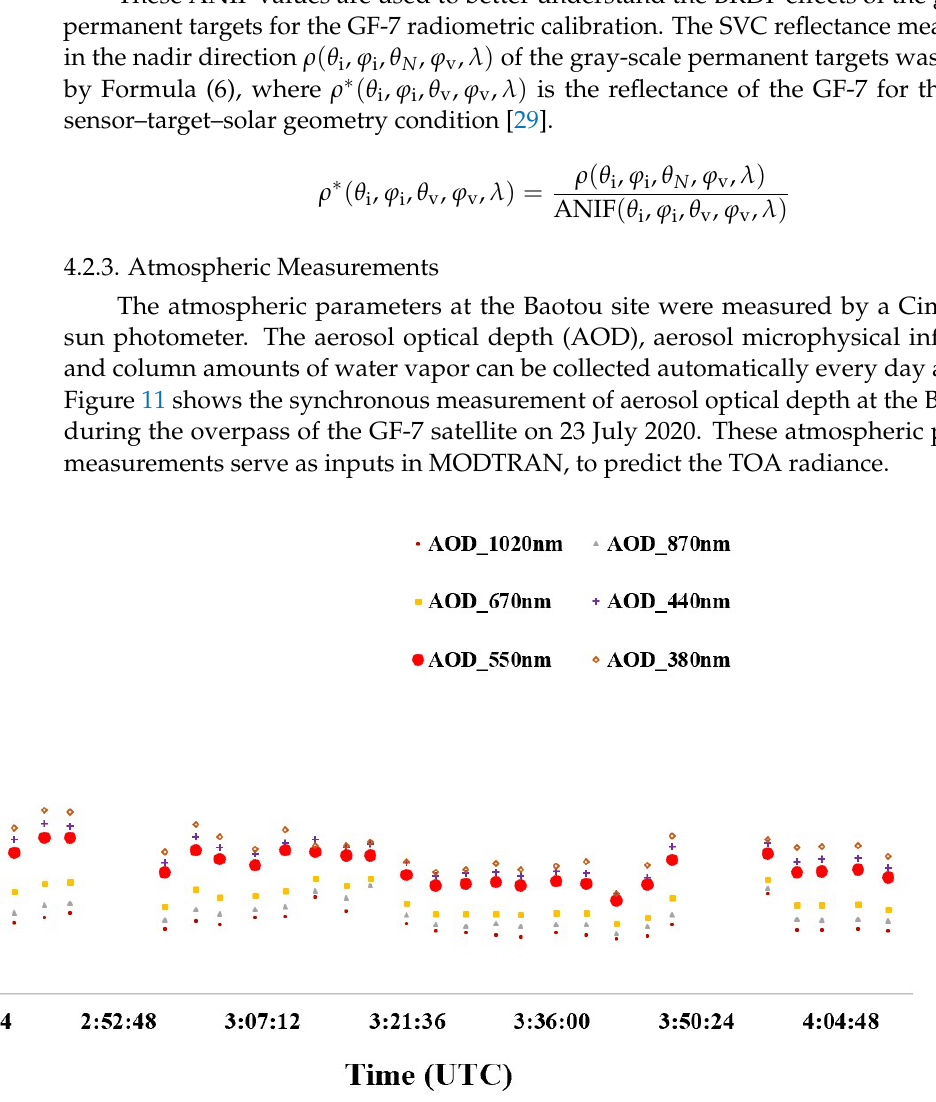
Figure 11. Synchronous measurement of the atmospheric parameters of the Baotou site on 23 July